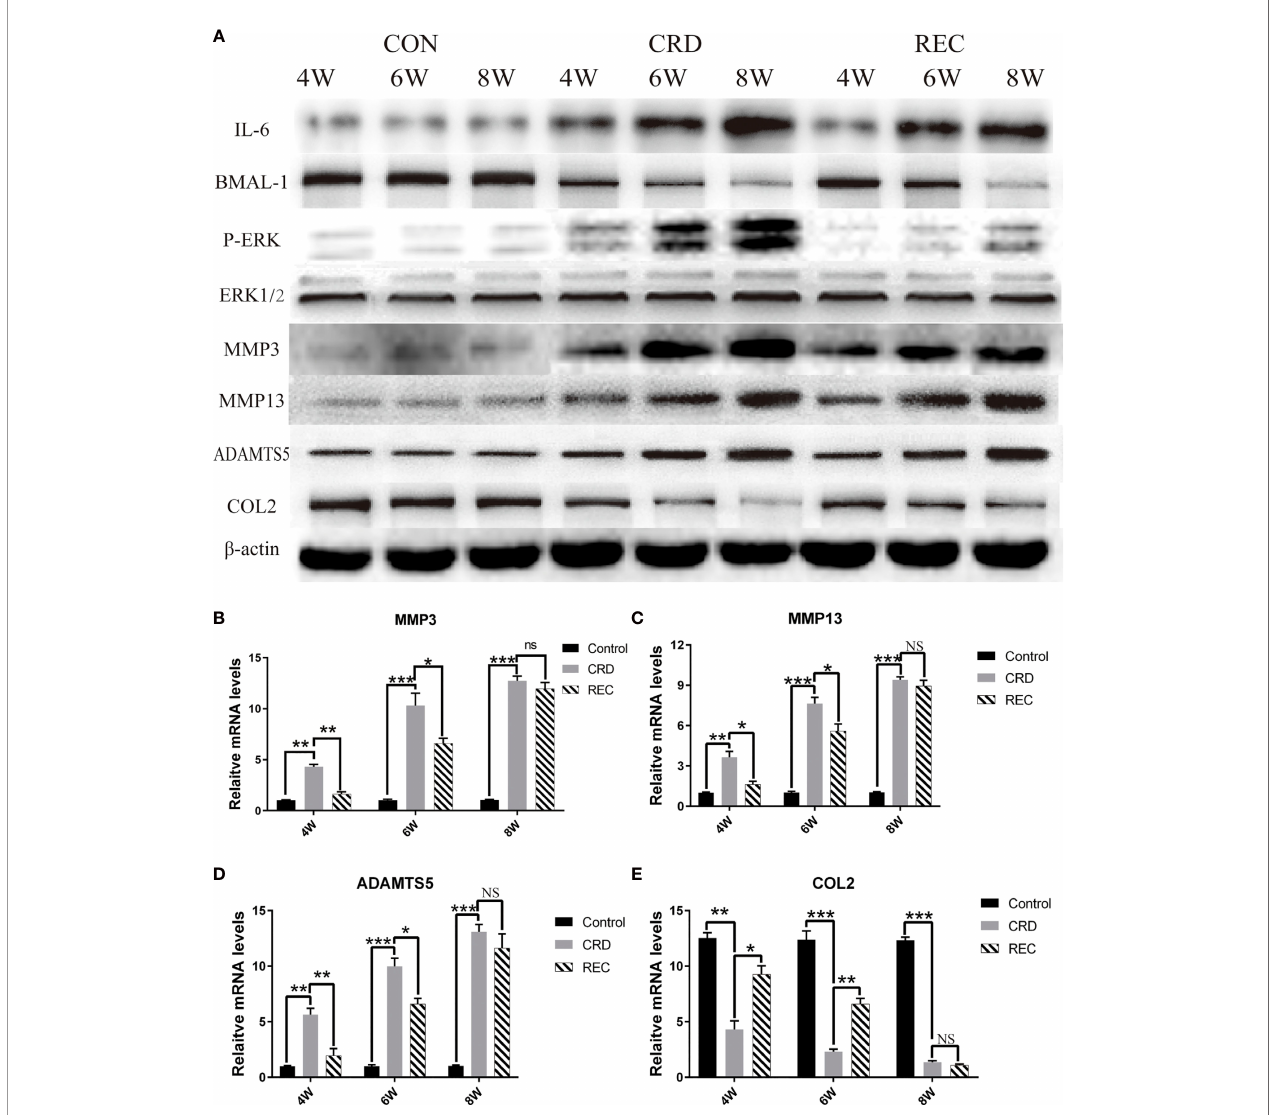
FIGURE 3 | Expression trends for IL-6/P-ERK/BMAL-1/MMP3/MMP13/ADAMTS5/COL2 in the CON, CRD, and REC groups. (A) Western blot results for IL-6/P- ERK/BMAL-1/MMP3/MMP13/ADAMTS5/COL2. (B – E ) RT-qPCR analysis of MMP3/MMP13/ADAMTS5/COL2. All experiments were performed in triplicate, and the results are expressed as the mean ± SD. *P < 0.05; **P < 0.01, ***P < 0.005. NS, not signi fi